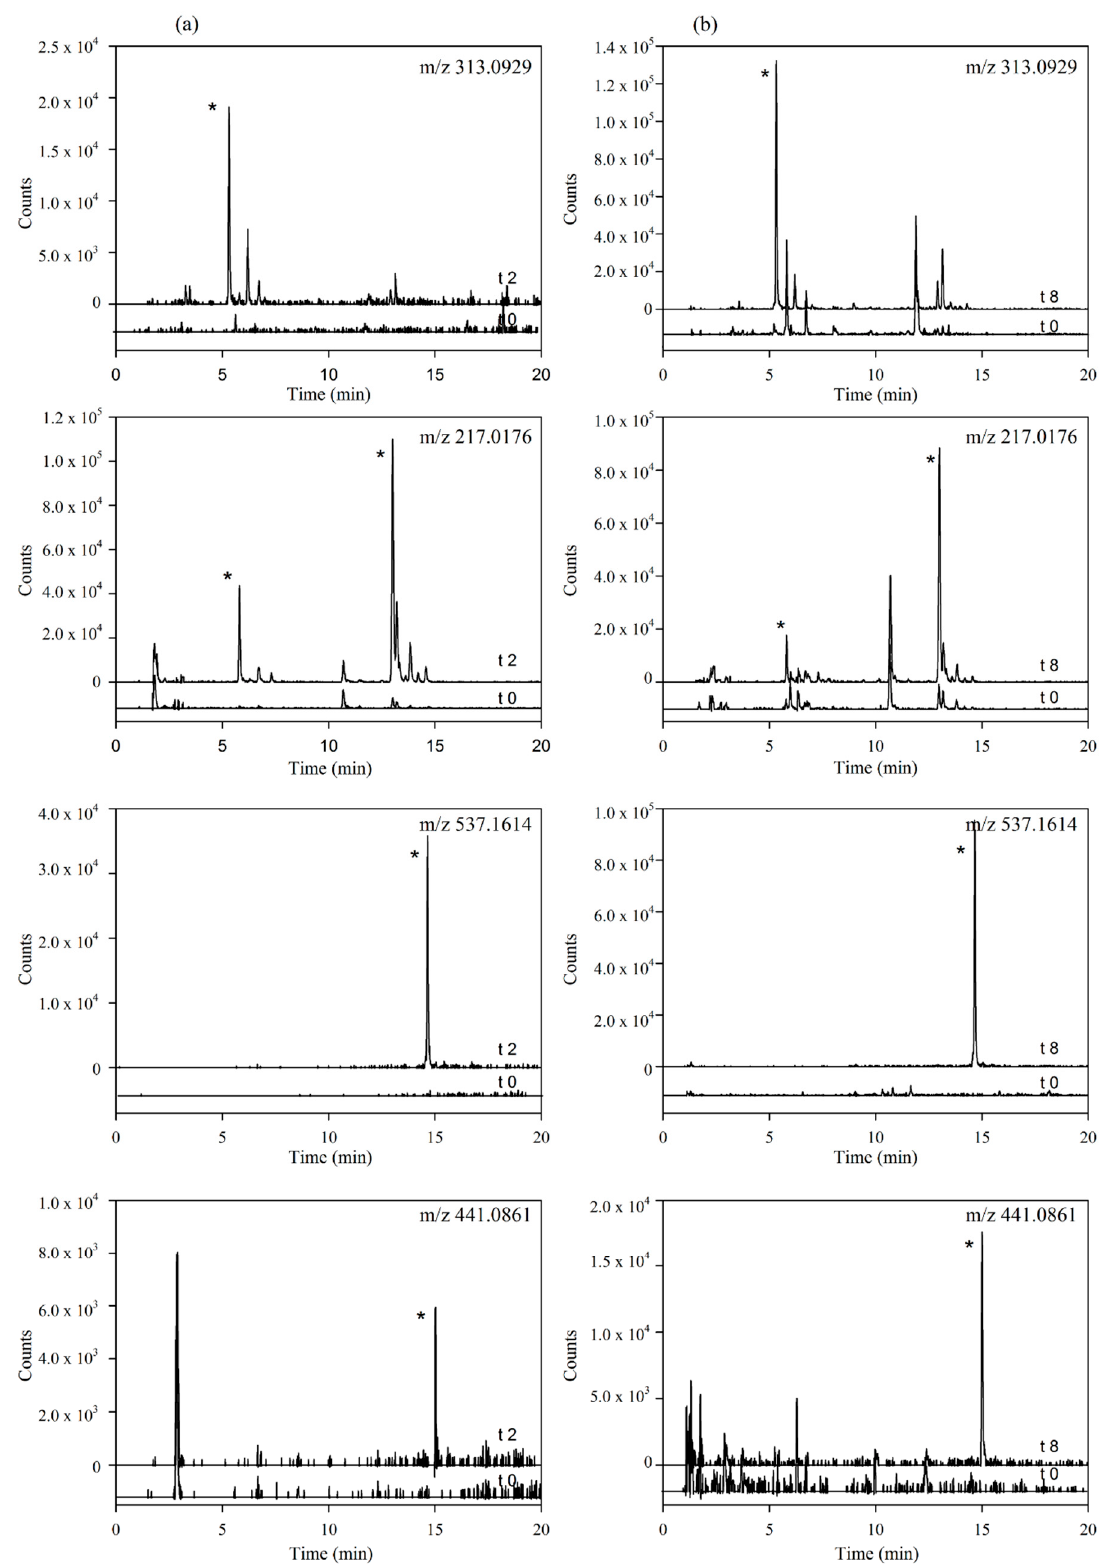
Figure 3. Extracted Ion Chromatograms (EICs) of the main targeted metabolites identified in ( a ) plasma samples (time 0 vs. 2 h) and ( b ) urine samples (time 0 vs. 8 h). (* indicate peaks corresponding to the metabolites identified for each mass in Table 2).